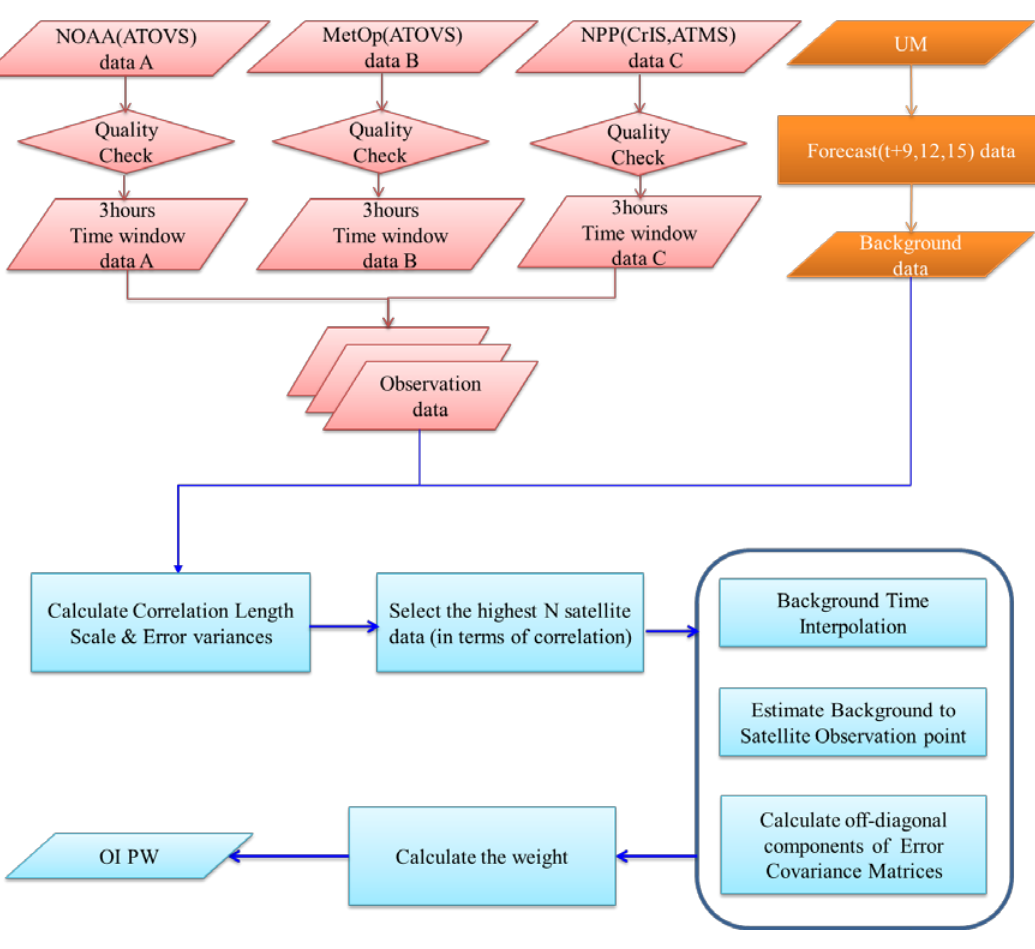
Figure 4. Optimal interpolation (OI) flowchart.